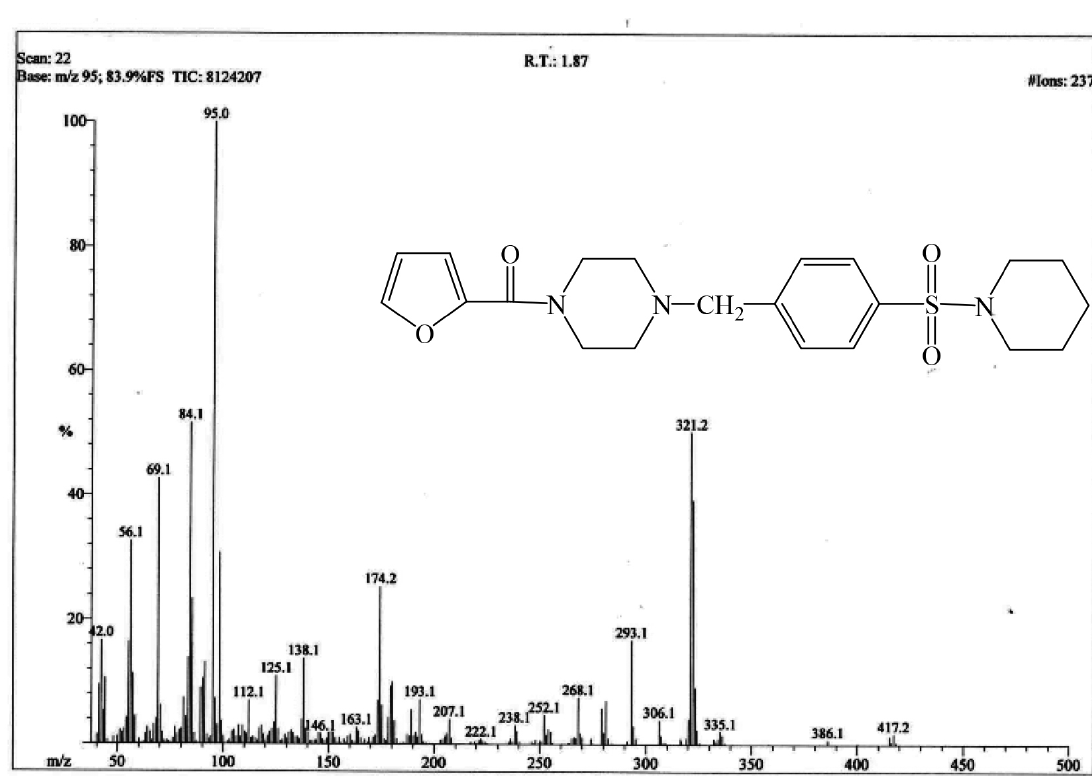
FIGURE 6 - EIMS spectrum of 2-furyl{4-[4-(1-piperidinylsulfonyl)benzyl]-1-piperazinyl}methanone ( 5c ).